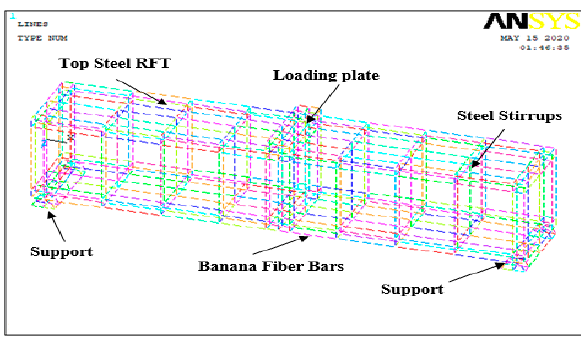
Figure 13. Model of reinforcement of beams (B2 to B5).